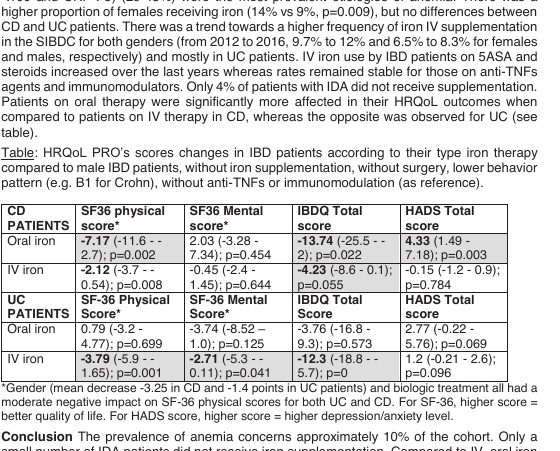
*Gender (mean decrease -3.25 in CD and -1.4 points in UC patients) and biologic treatment all had a moderate negative impact on SF-36 physical scores for both UC and CD. For SF-36, higher score = better quality of life. For HADS score, higher score = higher depression/anxiety level. Conclusion The prevalence of anemia concerns approximately 10% of the cohort. Only a small number of IDA patients did not receive iron supplementation. Compared to IV, oral iron supplementation seems to affect HRQoL outcomes in CD (gastrointestinal intolerance, undertreatment) whereas IV supplementation rather affects UC